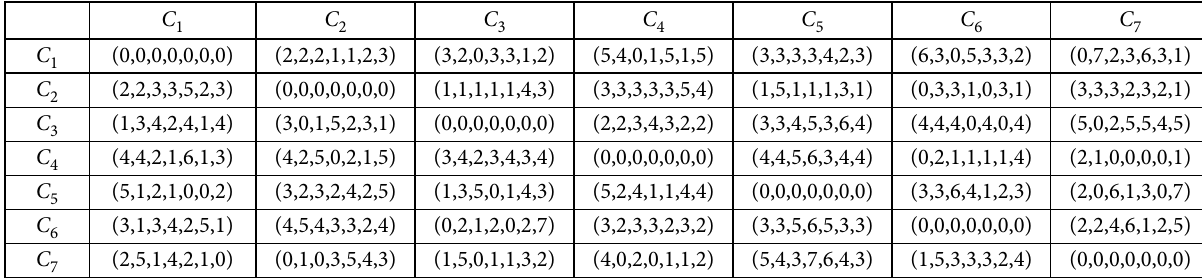
Table 2. Initial experts’ comparison for DEMATEL